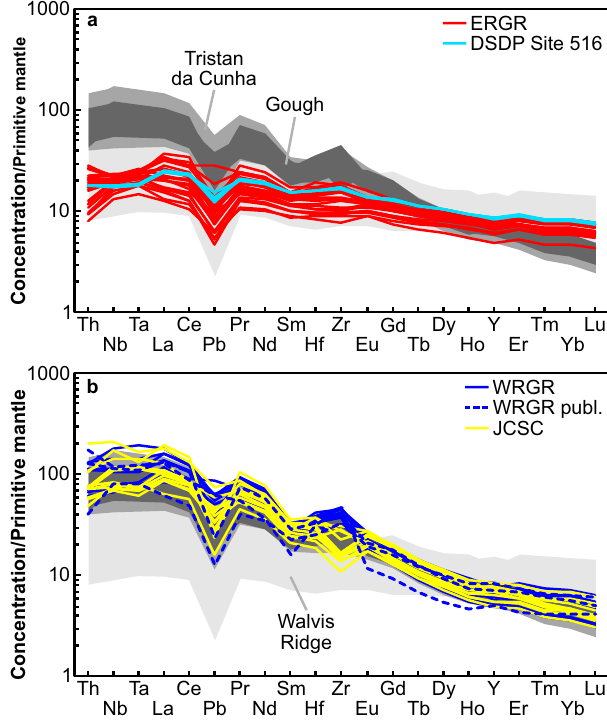
Fig. 3 Primitive mantle 58 normalized multielement variation diagrams showing geochemical differences between the tholeiitic lavas from the Rio Grande Rise and the alkaline lavas from the Rio Grande Rise and Jean Charcot Seamount Chain (JCSC). a The lavas samples from the Eastern Rio Grande Rise (ERGR) and Deep Sea Drilling Program (DSDP) Site 516 display trace element patterns similar to those of the Walvis Ridge 15,52 . b The lava samples from the Western Rio Grande Rise (WRGR) and JCSC exhibit trace element patterns similar to those of Tristan da Cunha and Gough. Note samples with MgO concentrations of <2 wt.% MgO are not